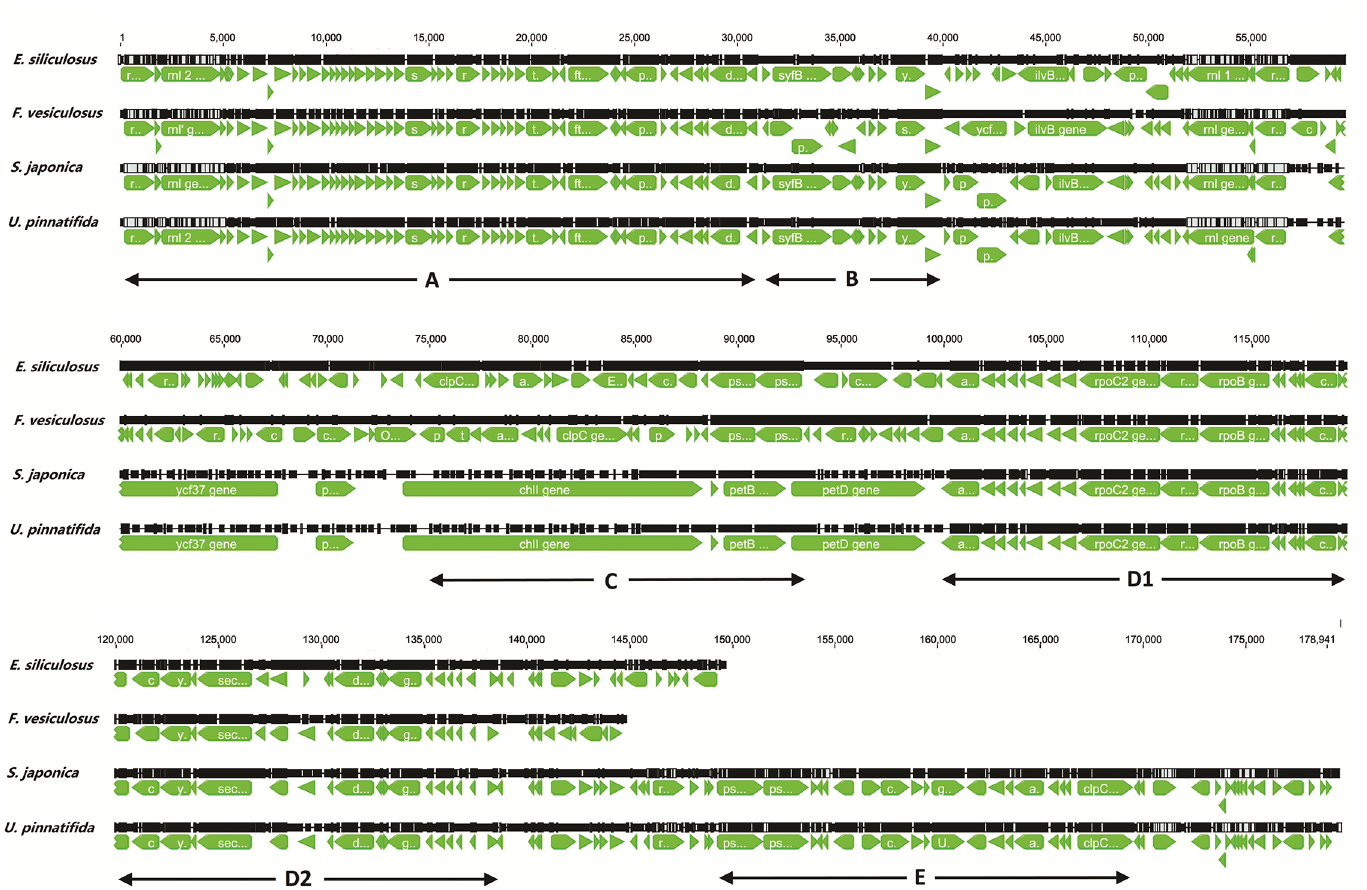
Fig 2. Comparison of four large brown algal plastid genomes by using the Geneious software. Letters A to E with two-header arrows correspond to the specified area of each species.